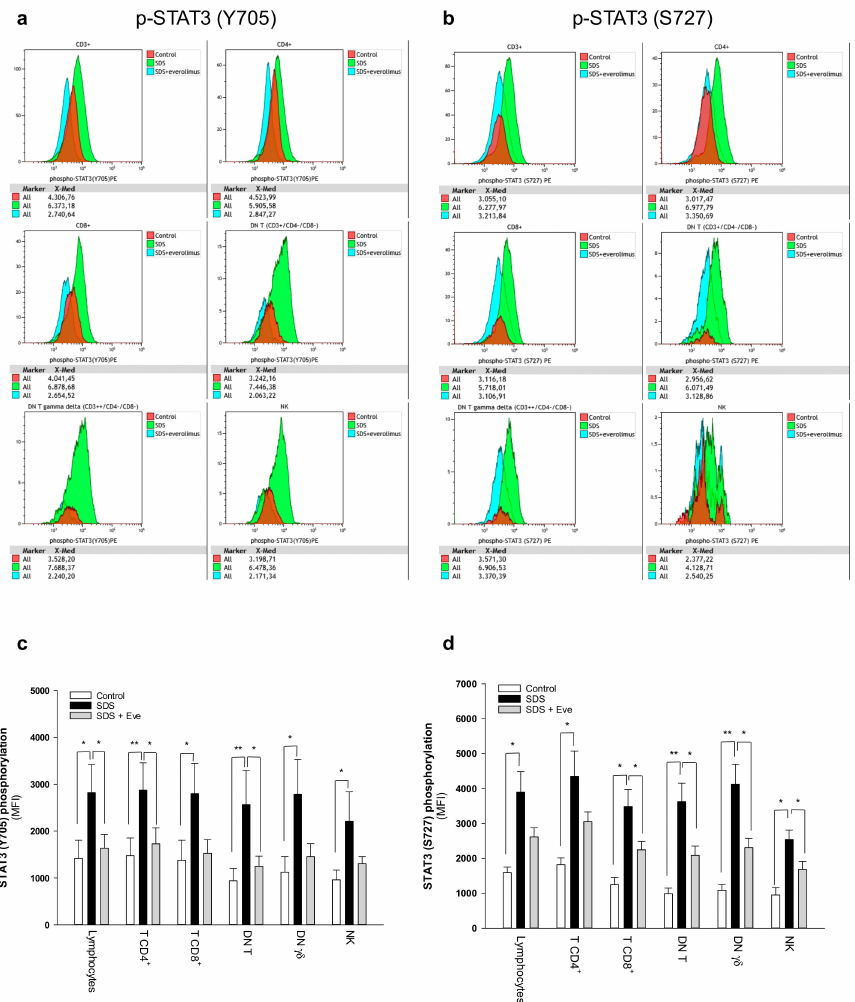
Figure 2. Phospho-flow analysis of STAT3 in a panel of primary lymphocyte subsets. ( a ) Representative analysis of phospho-STAT3 Y705 in lymphocyte subsets. ( b ) Representative analysis of phospho-STAT3 S727 in lymphocyte subsets. Red histograms represent age-matched healthy control cells; green histograms represent SDS patient-derived lymphocytes; blue histograms represent SDS lymphocytes upon everolimus (350nM) treatment. Data are mean ± SEM of seven experiments conducted on SDS patient-derived lymphocytes obtained from seven SDS patients (UPN37, UPN58, UPN69, UPN73, UPN87, UPN106, UPN108). Statistical Student’s t test for paired data has been calculated. * p < 0.05; ** p < 0.01. ( c ) STAT3 (Y705) Median Fluorescence Intensity as measured by phospho-flow assays. ( d ) STAT3 (S727) Median Fluorescence Intensity as measured by phospho-flow assays. Data are mean ± SEM of seven experiments conducted on SDS lymphocytes obtained from seven SDS patients (UPN37, UPN58, UPN69, UPN73, UPN87, UPN106, UPN108). Statistics: Normal distribution was tested